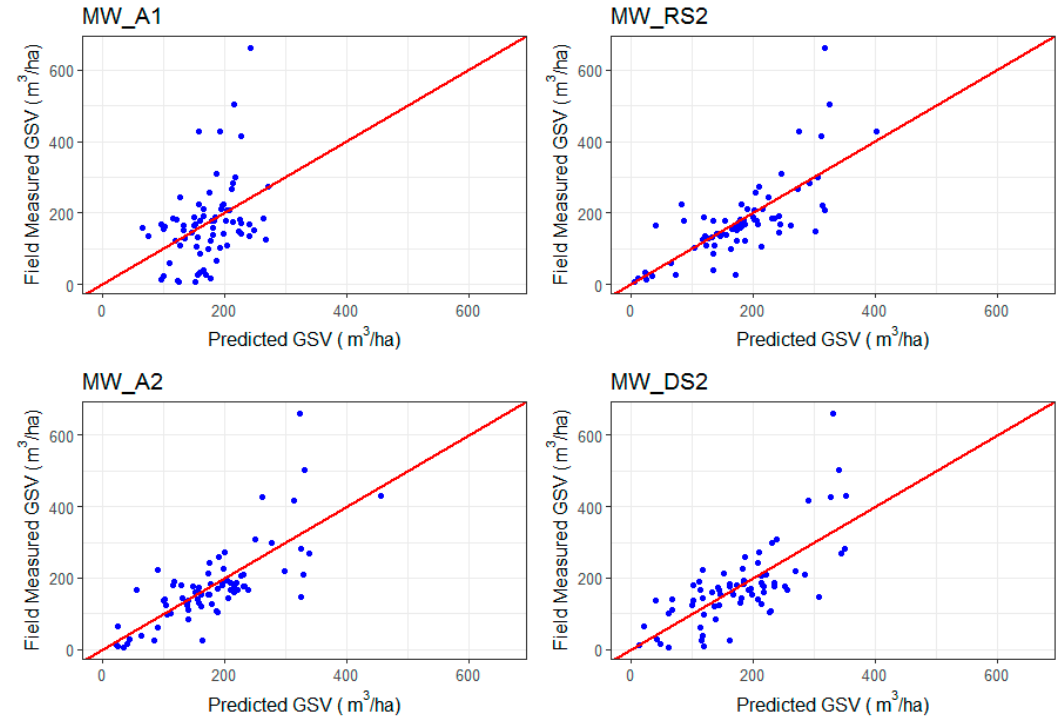
Figure 8. Scatter plot of field measured GSV versus predicted GSV for models fitted using MW based predictor variables.